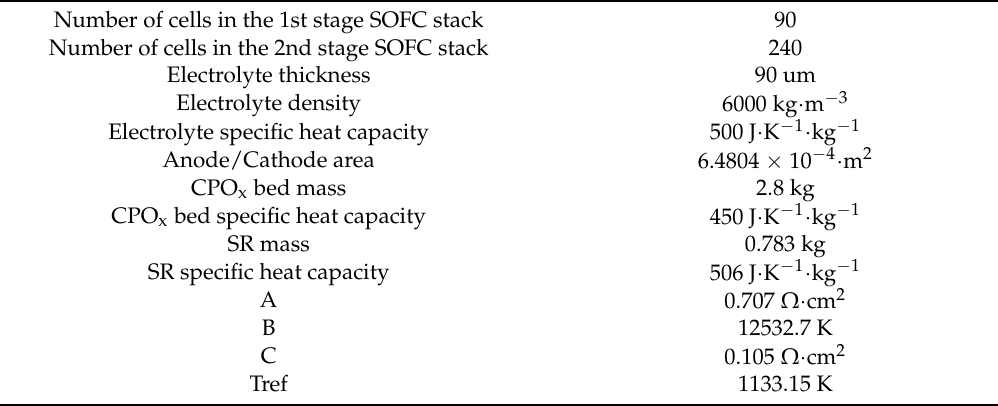
Figure 2. Model layout of the power SOFCs-based system. Table 1. Simulation parameters obtained from the project partner based on measurements